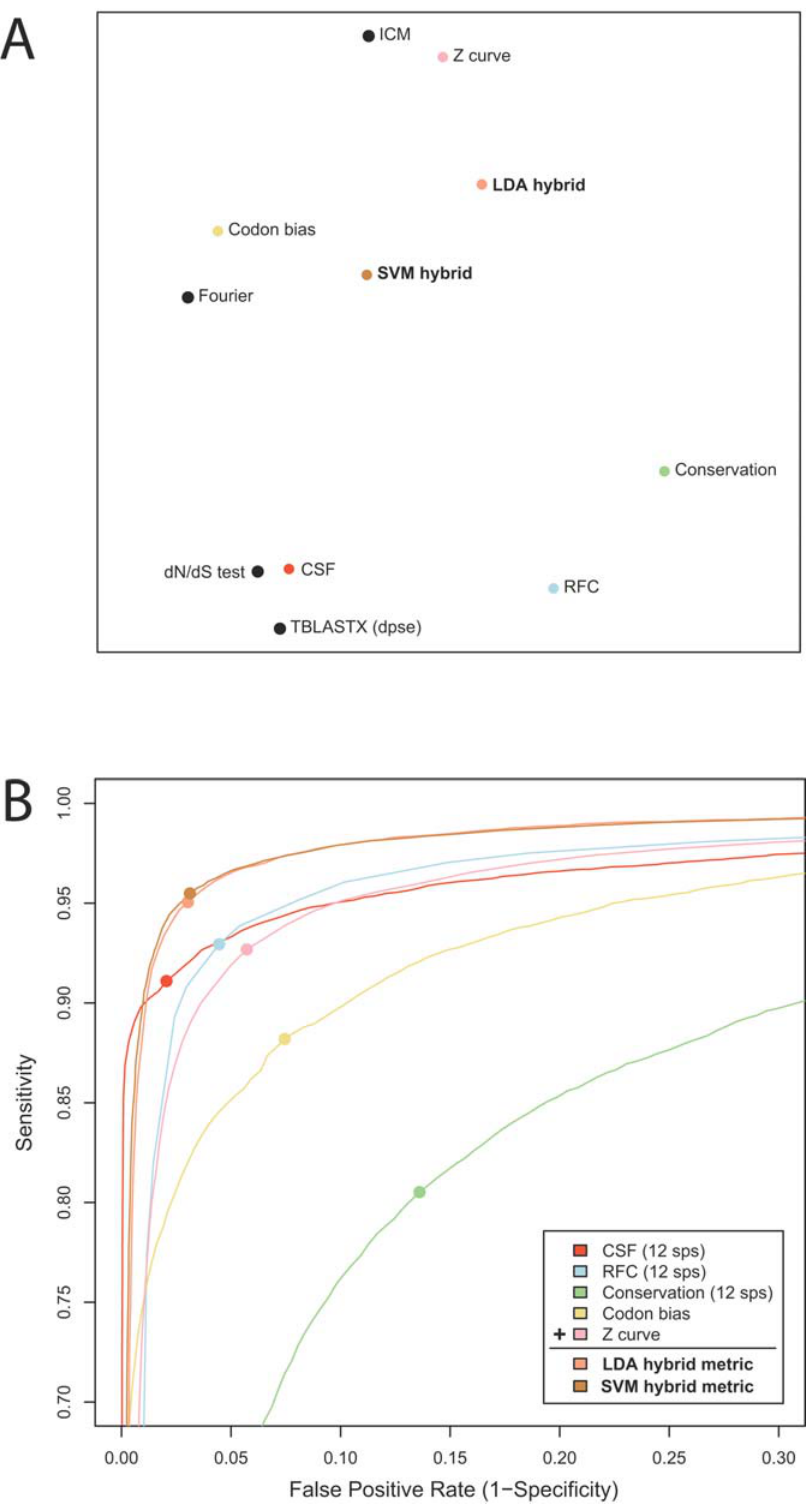
Figure 2. Independence of metrics and discovery power of metric combinations. (A) Multidimensional scaling (MDS) visualization in which each point represents a metric and the distance between any two points approximately represents their dissimilarity, measured as 1-(rank correlation of the scores of the known exons). Hybrid metrics appear closer to the center, suggesting that they successfully combine distinct information from the individual metrics. (B) ROC curves showing the performance of two hybrid metrics created by combining five comparative and single-sequence metrics using Linear Discriminant Analysis (LDA) or a Support Vector Machine (SVM). The hybrid metrics outperformed all of their input metrics.